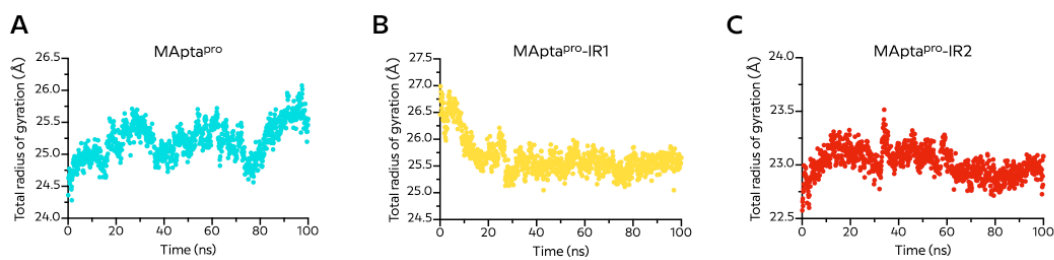
Figure 8. Time evolution of the radius of gyration (Rg) for ( A ) MApta pro , ( B ) MApta pro -IR1, and ( C ) MApta pro -IR2 in complex with M pro protein during 100 ns molecular dynamics simulation.